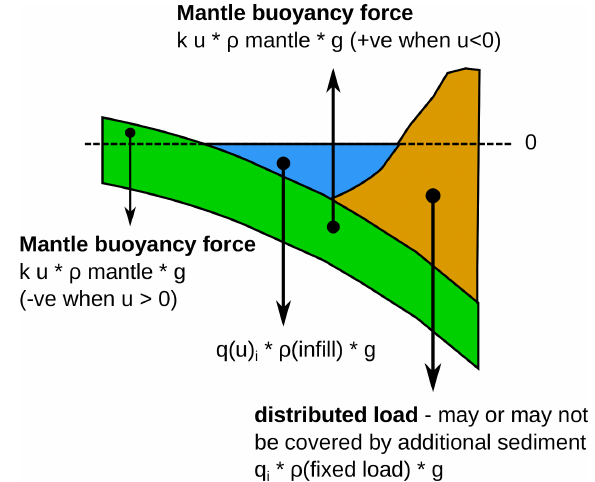
Figure A1. Sketch showing the different components of the total load q(u) and the restoring force due to mantle displacement in the model. Table A1. Standard parameters used in numerical models